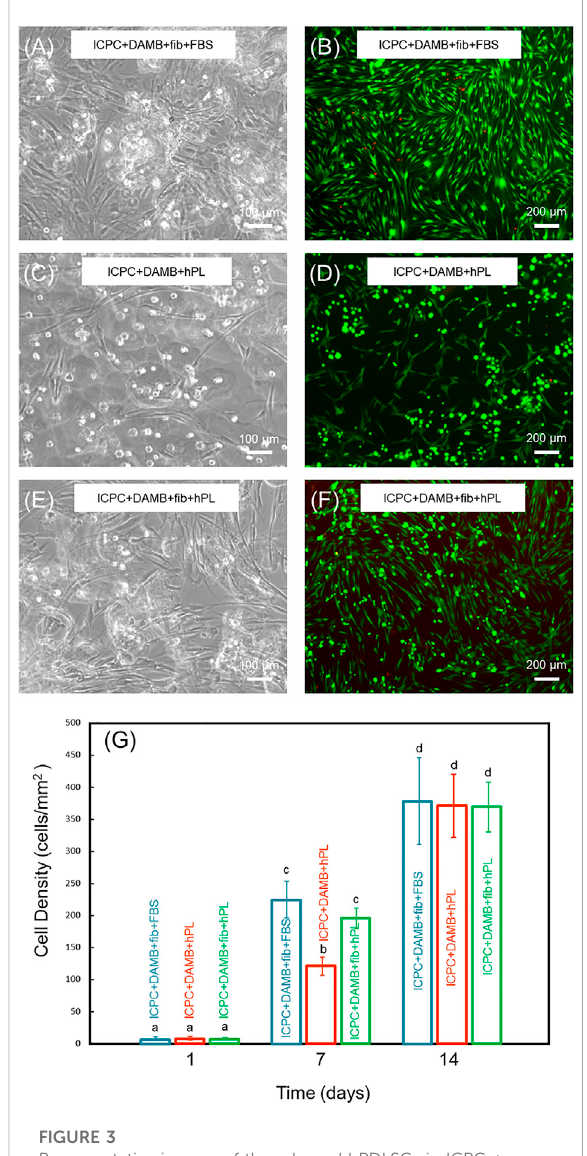
FIGURE 3 Representative images of the released hPDLSCs in ICPC + DAMB + fi brin + FBSgroup (A,B) ,ICPC + DAMB + hPL group (C,D) , and ICPC + DAMB + fi brin + hPL group (E,F) at 7 days. The cell densityofthereleasedcellsat1,7,and14 days (G) .Eachvalue is (mean ± sd; n = 4). Bars with dissimilar letters indicate signi fi cantly different values.